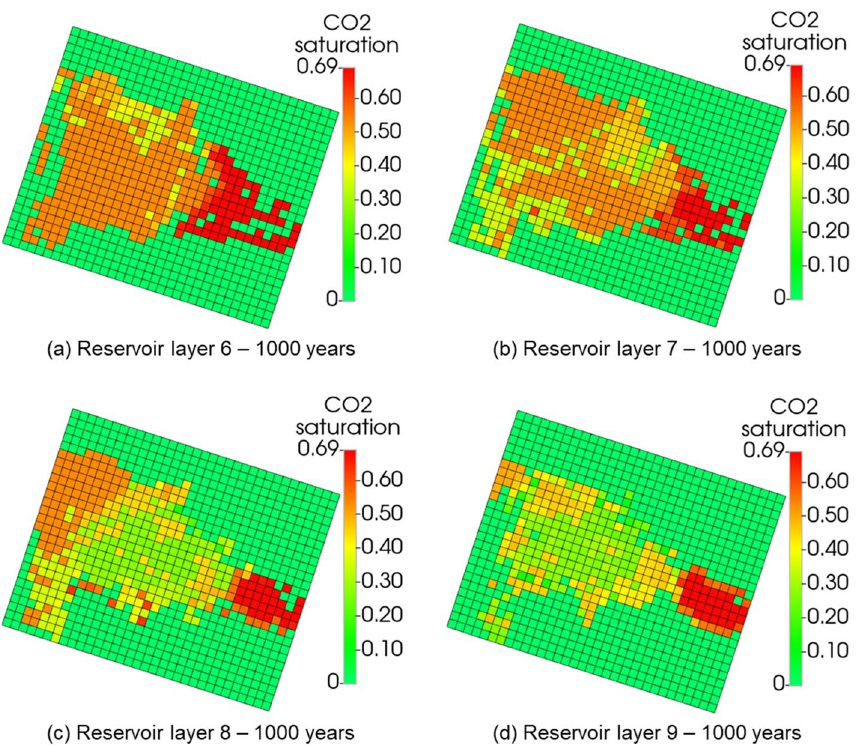
Figure 9. CO 2 in the reservoir layers at the end of the 1000 years of post-injection